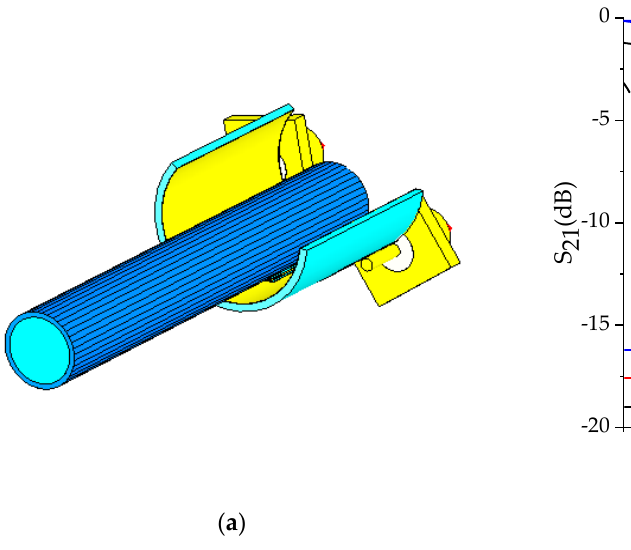
Figure 8. Designed sensor in the CST interface: ( a ) bended structure; ( b ) S 21 response of water–ethanol mixtures for different bending radii and concentrations.